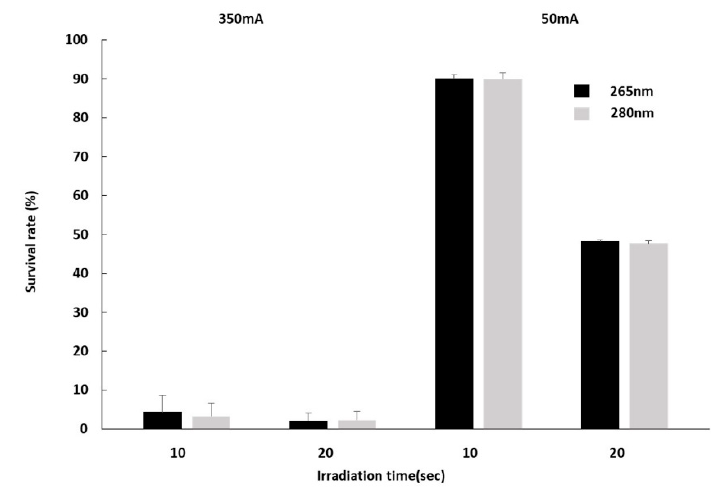
Figure 5. Evaluation of HaCaT cell damage by DUV-LED light. The survival rates of HaCaT cells after irradiation with 265 nm LED (black bars) and 280 nm LED (grey bars) are shown for the application of 350 mA or 50 mA of current. Error bars indicate standard error.